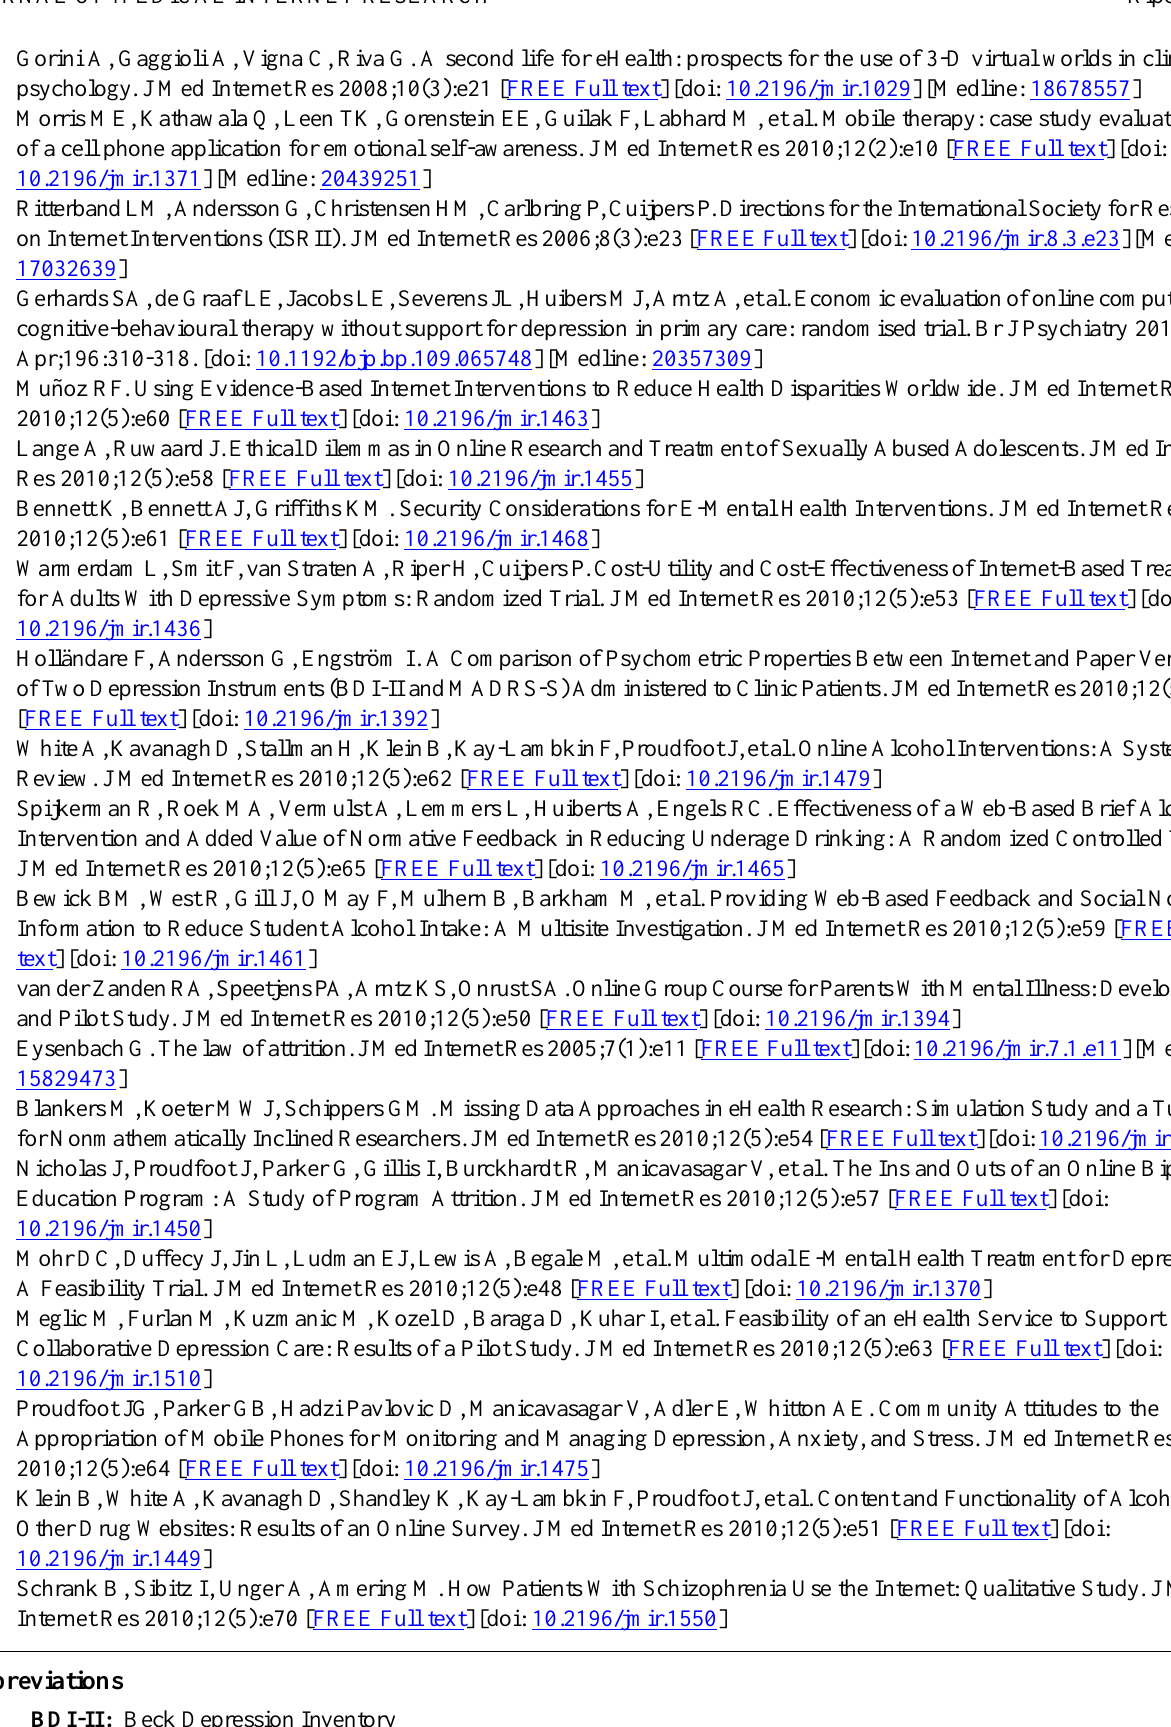
Abbreviations BDI-II: Beck Depression Inventory CBT: cognitive behavioral therapy GAD: general anxiety disorder